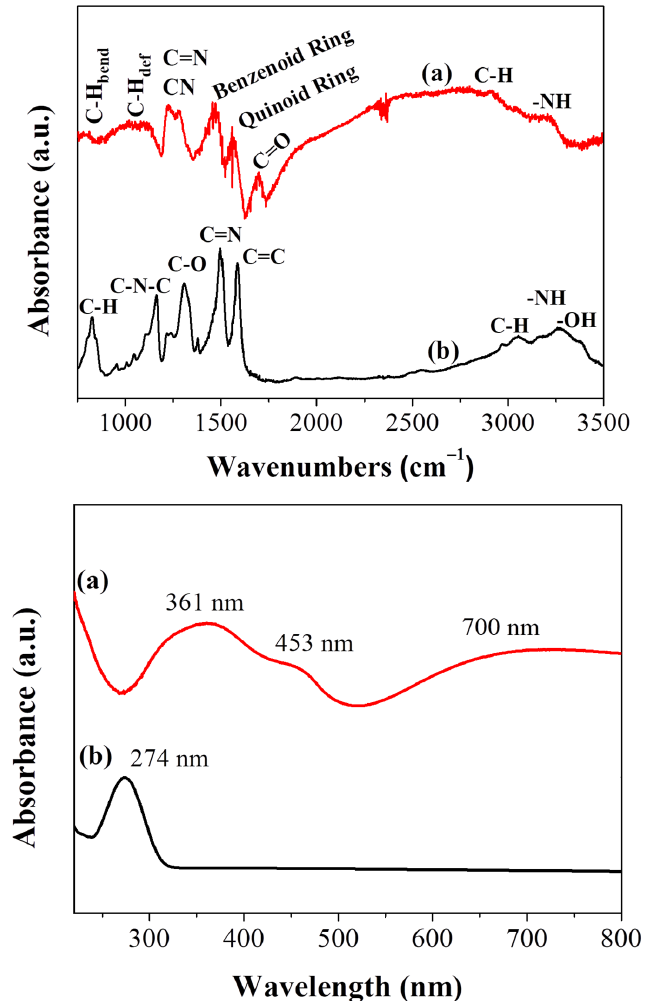
Figure 2. ATR-IR spectra ( top ) and UV-vis spectra ( bottom ) of ( a ) PANI and ( b ) carbon nanosheets.